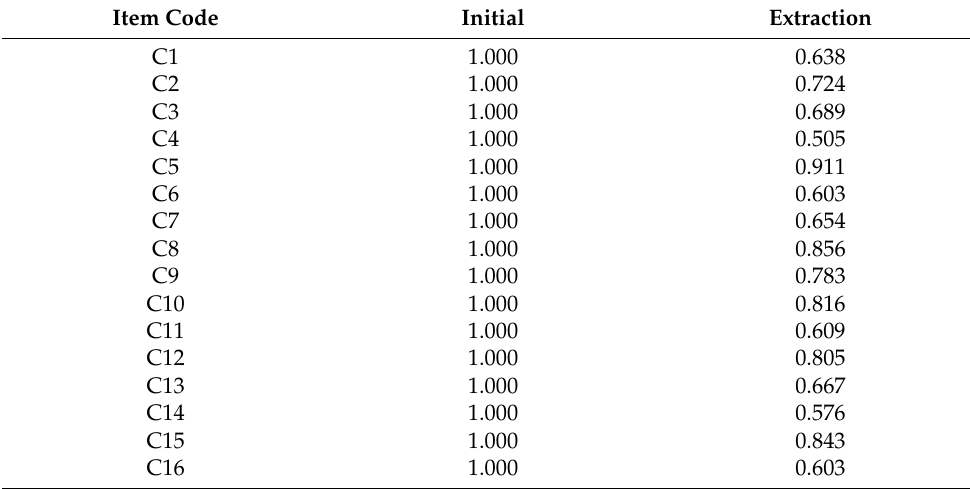
Table 4. Communalities of